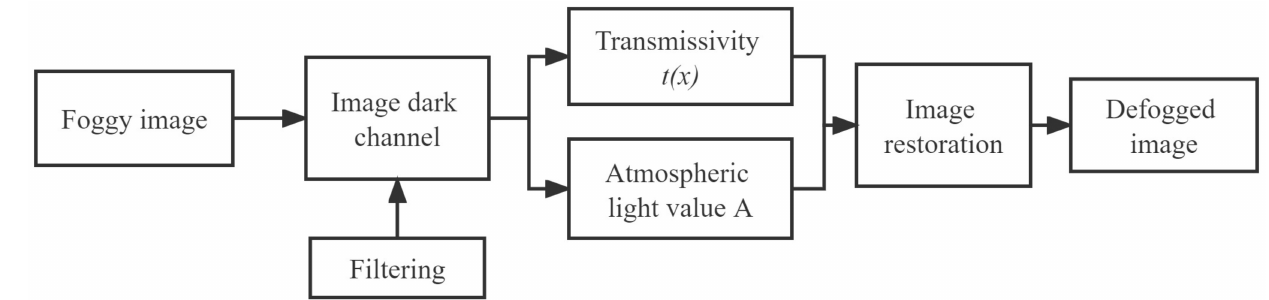
Figure 2. Process flow of the dark channel defogging